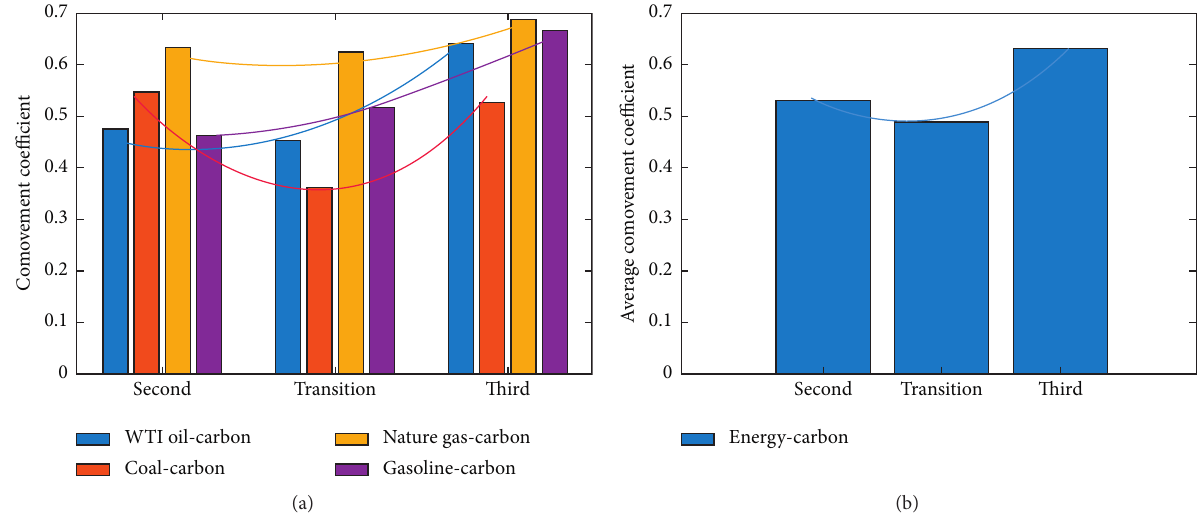
Figure 6: (a) Linkage relationship between crude oil, coal, natural gas, gasoline, and carbon prices in different stages. (b) Average linkage between energy and carbon